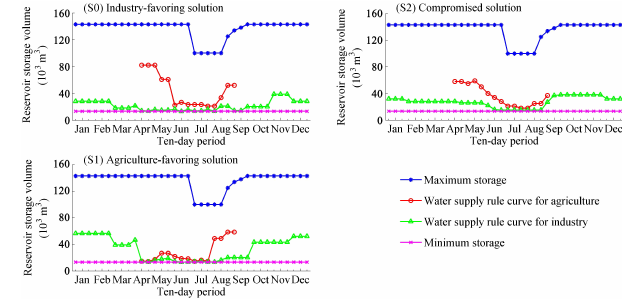
Figure 7. Computational savings for two hypervolume values – (a) hypervolume = 0 . 80 and (b) hypervolume = 0 . 85.